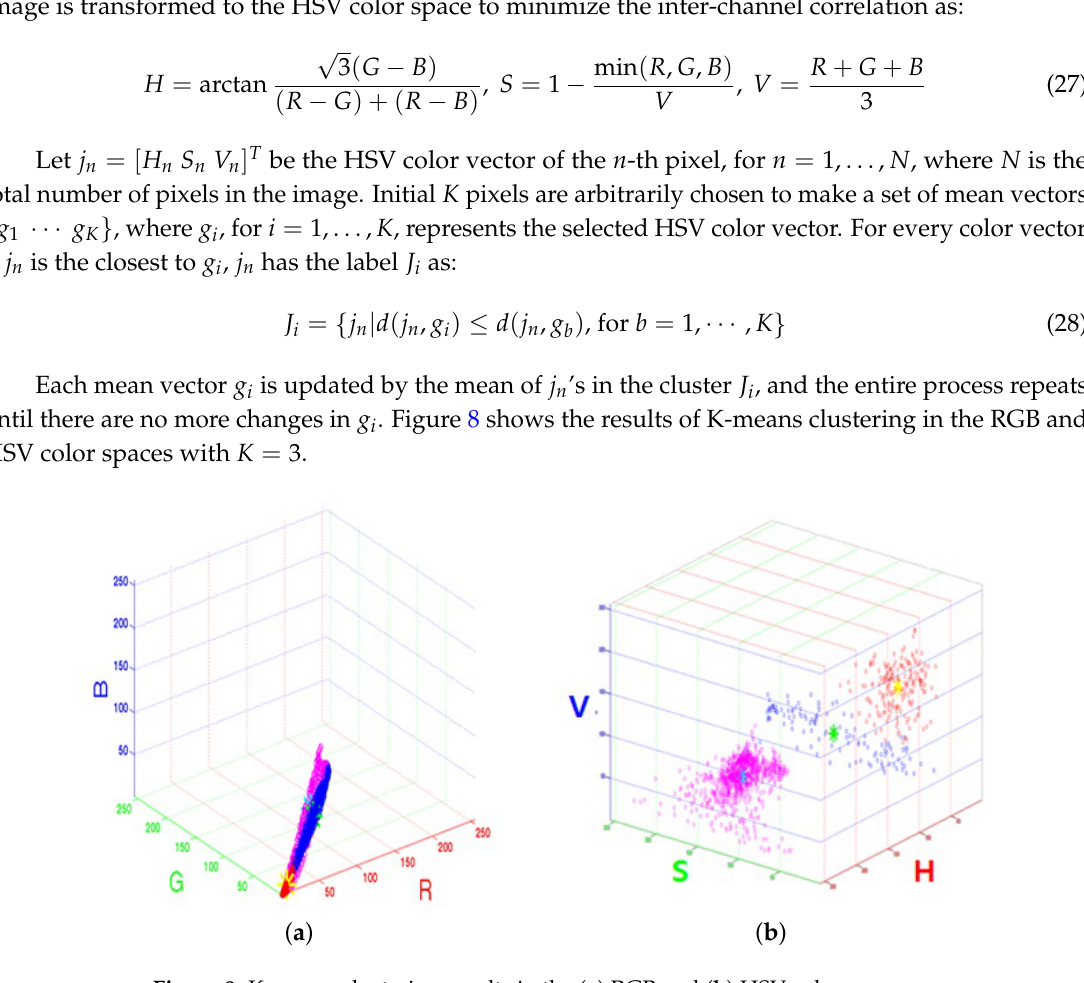
Figure 8. K-means clustering results in the ( a ) RGB and ( b ) HSV color